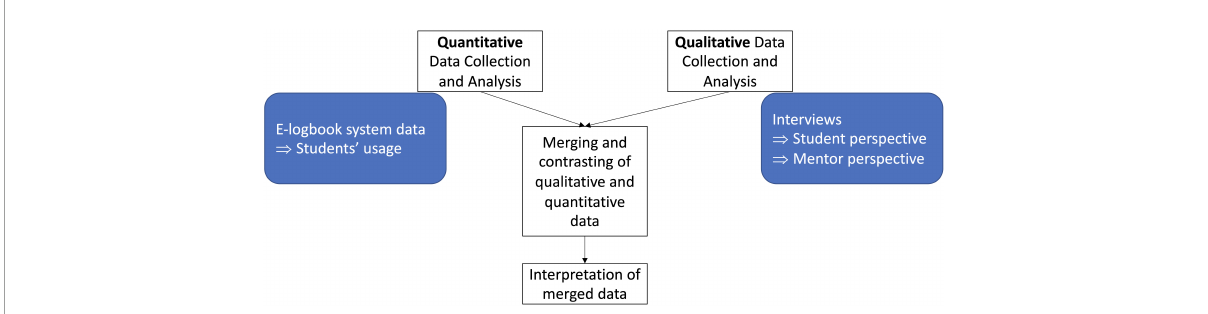
FIGURE2 Overview of convergent mixed-methods design, in which quantitative and qualitative findings were combined and contrasted to achieve a holistic understanding of the collected data. Quantitative data collection included data from the e-logbook system, i.e., student usage data; qualitative data collection included data collected through in-depth interviews with students and